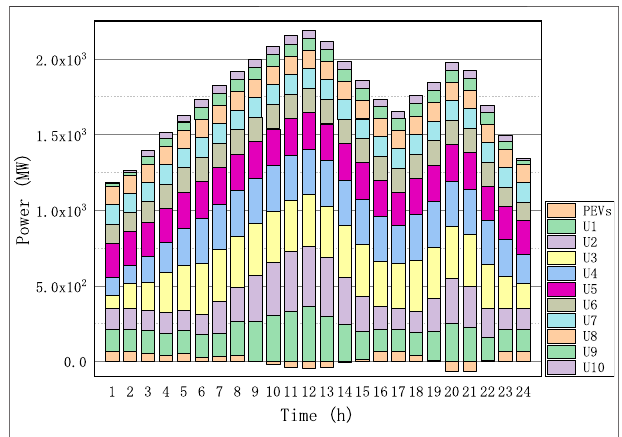
FIGURE5| Thepoweroutputofthe10unitswithanorderlyPEVspower